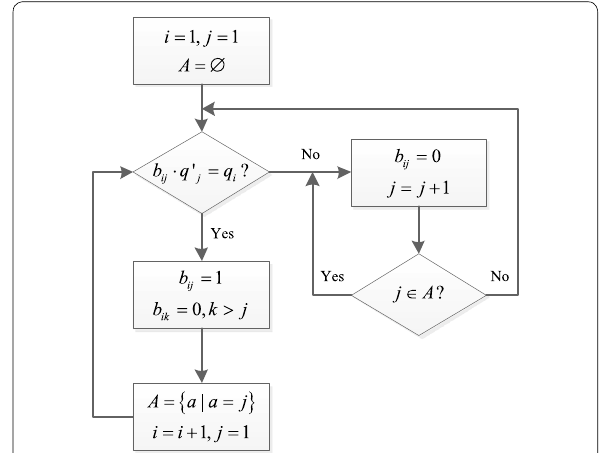
Figure 2 The calculation procedure of rearranged